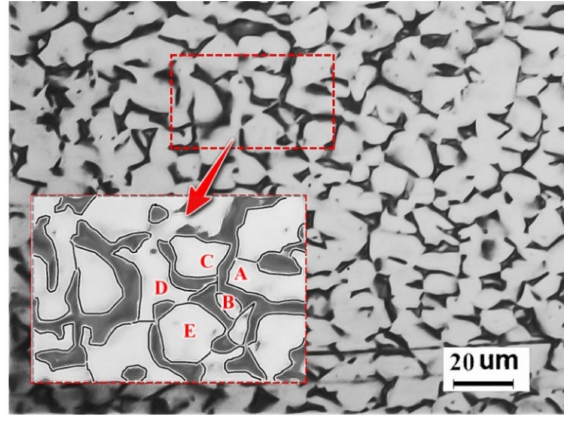
Figure 8. Optical microscopy of sample at 920 ◦ C and strain rates of 10 − 3 /s.